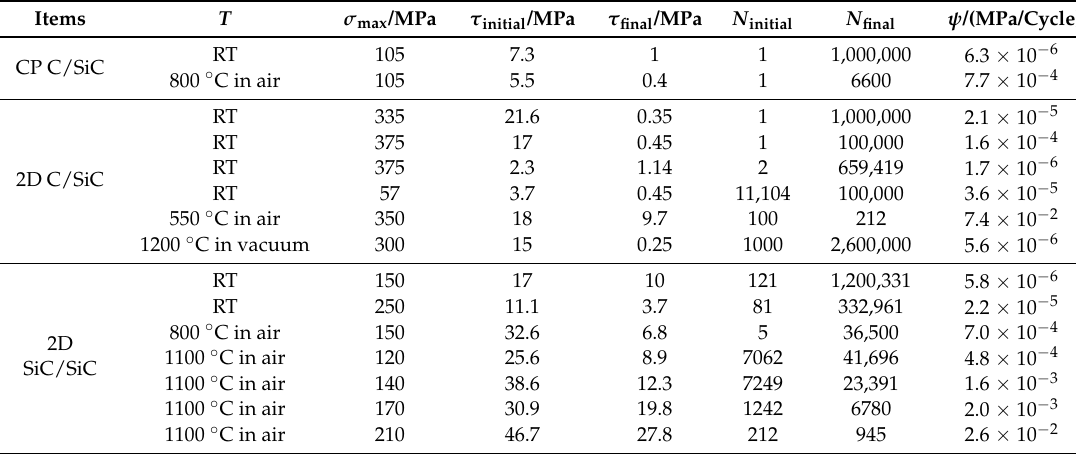
Table 12. The interface shear stress degradation rate of C/SiC and SiC/SiC composites at room and elevated temperatures.